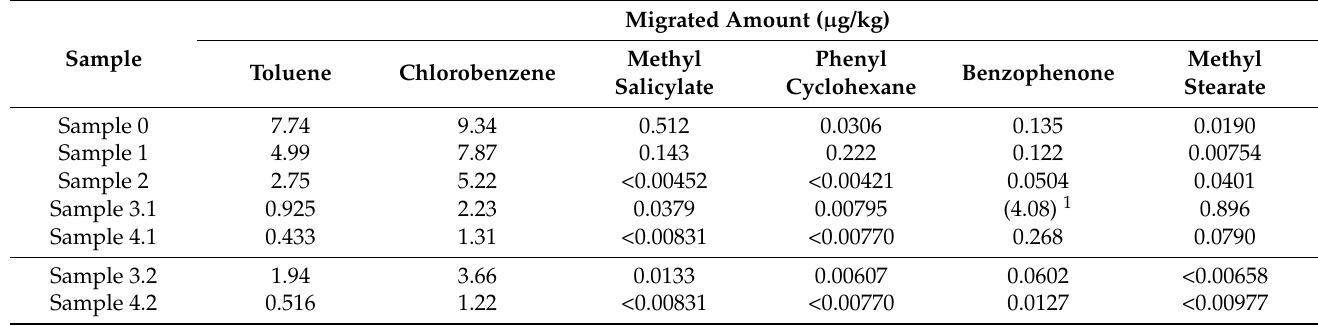
Table 5. Migrated amounts of the surrogates and styrene into the gas phase from yogurt cups after storage for 10 days at 40 ◦ C (pre-storage time for Samples 3.2 and 4.2 is 14 months; pre-storage time for all other samples is 7 months). Spiked amount normalized to 30